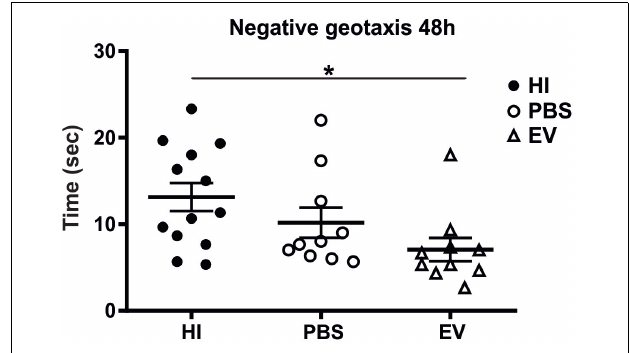
FIGURE 4 | Intranasal application of MSC-derived EVs, immediately following HI reduces the time required to change orientation in negative geotaxis following neonatal HI at 48 h (postnatal day 11). Intranasal treatment with MSC-derived EVs immediately following HI significantly reduces the time necessary for change of orientation compared to HI and PBS-treated littermate controls (Kruskal–Wallis test, p = 0.0151, Dunn’s test EV vs. HI ∗ p =